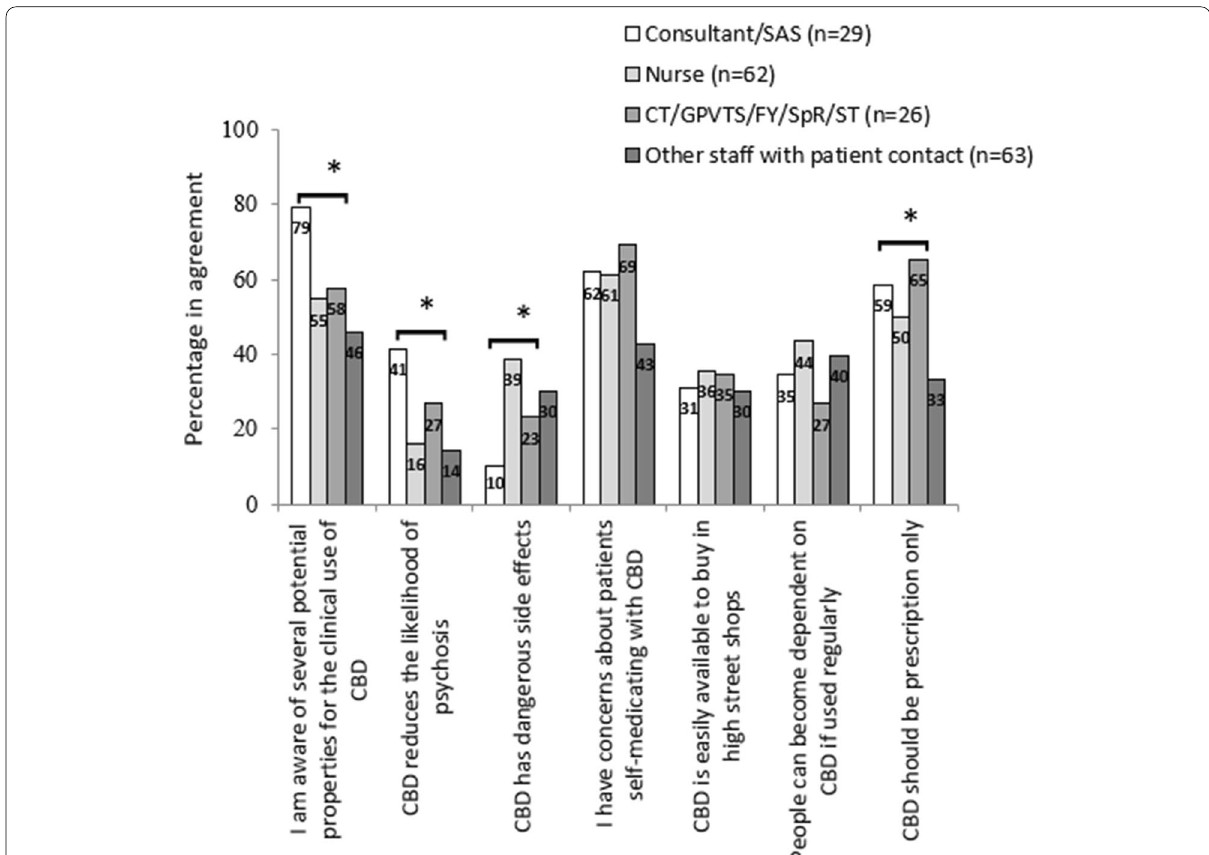
Fig. 1 Staff attitudes toward the medical use of cannabidiol, by professional role (percentage responding either ‘agree’ or ’strongly agree’). Data labels represent percentages; differences are on chi-square testing; * p <